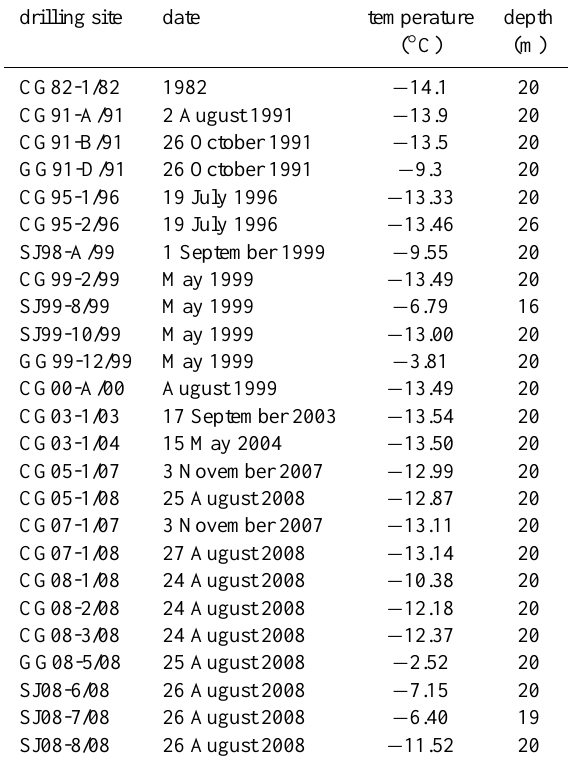
Table 2. Information about temperatures measured at 20m depth for all measurement sites with measurement number, date and